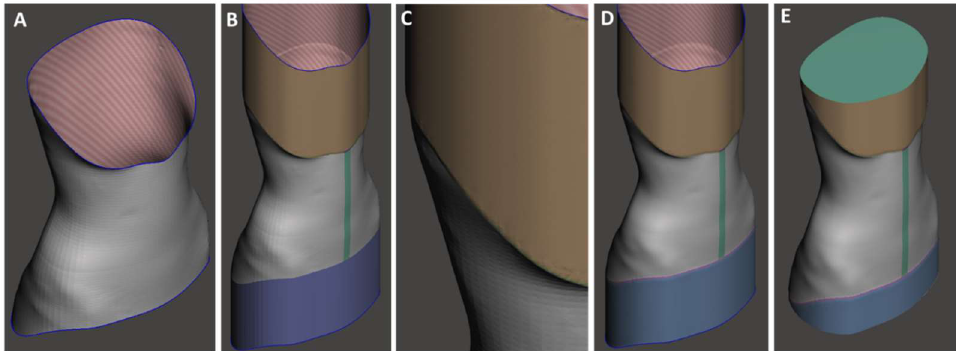
Figure 3. CAD design using a specialized software for O&P products (Neo, Rodin4D, Merignac, France).